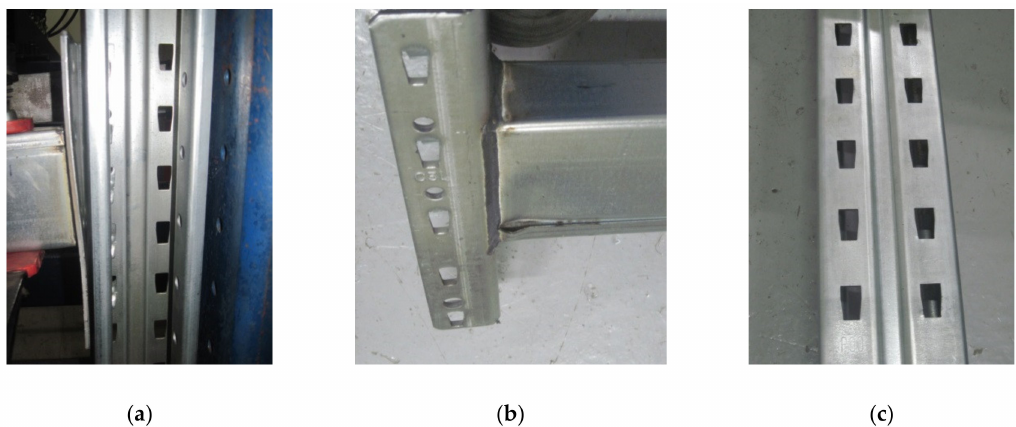
Figure 17. Failure modes in case of the assembly with the upright region having a thickness equal to 2.00 mm and a connector with five tabs: ( a ) failure mode of the connector, ( b ) failure mode of the beam, and ( c ) failure mode of the upright region.